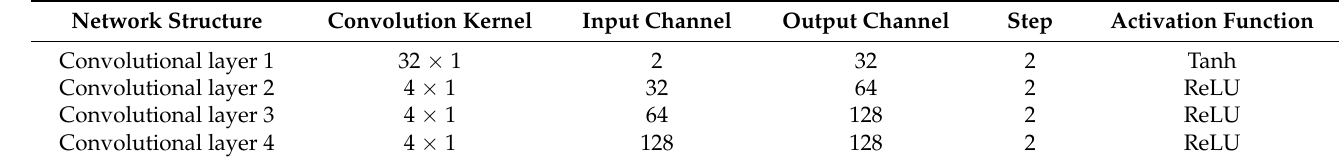
Table 3. Network structure of MC1DCNN.